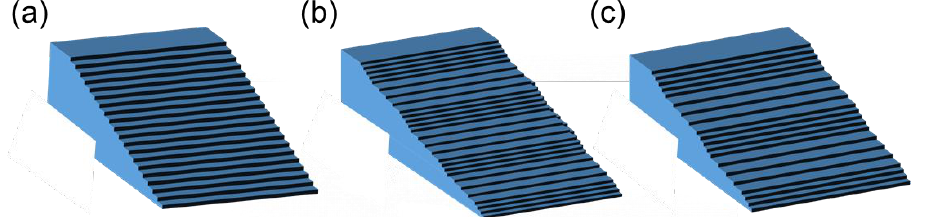
Figure 3. Schematic figures of the separation-undulated step structures on a vicinal crystal surface, where the undulation wavelength of step separation (terrace width) increases from ( a ) to ( b ) to ( c ).